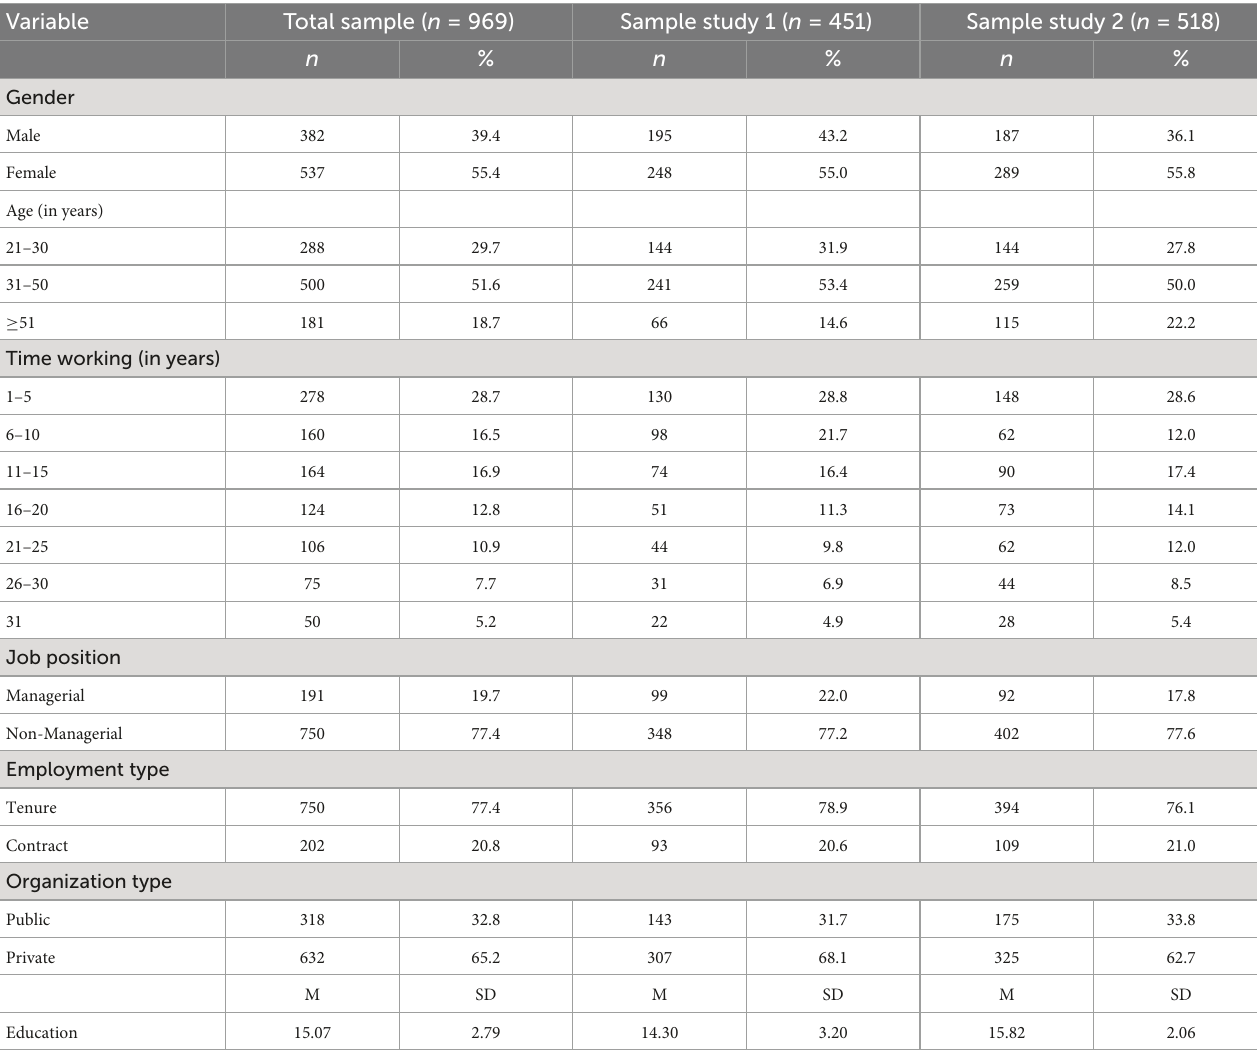
TABLE 2 Sociodemographic characteristics of the sample. Variable Total sample ( n =